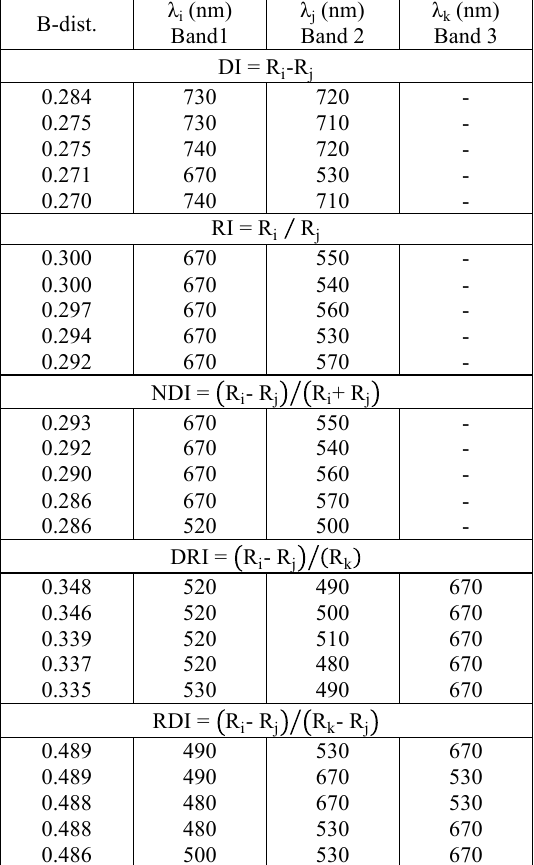
Table A.1. Best five wavelengths combinations for each vegetation index